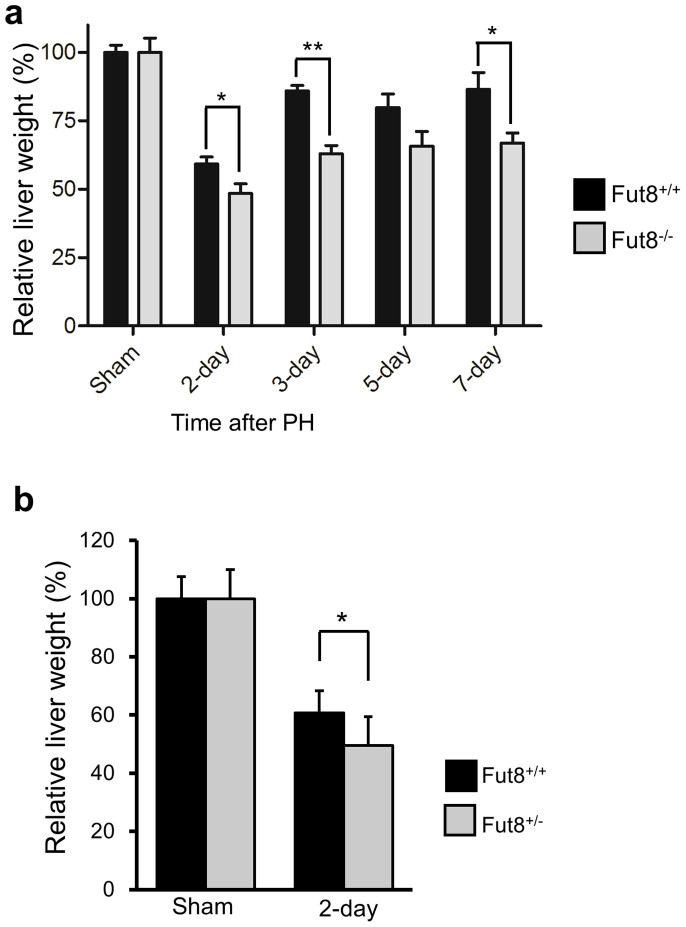
Fut8 expression was required for liver regeneration after PH.7- to 8-week-old mice were surgically resected as described in “Methods”, and then the livers were harvested at the indicated times. (a) Relative liver weight (liver vs whole body) at the indicated times after 70% PH. The sham group was set as 100%. Each set of the reported data was obtained from at least 5 individuals of Fut8+/+ and Fut8−/− mice. *, P < 0.05; **, P < 0.01. (b) Comparison of relative weight at 2 days after PH between Fut8+/+ and Fut8+/− mice (C57BL/6 genetic background). Each data was obtained from at least 8 individuals. *, P < 0.05, compared with the Fut8+/+ mice.